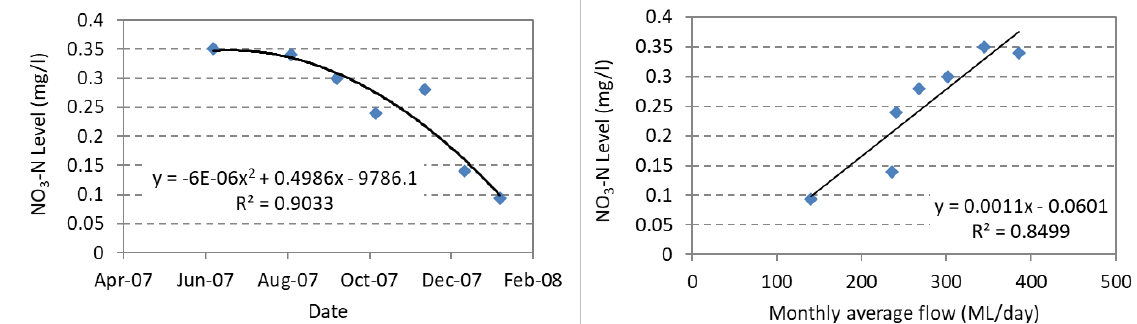
Figure 4. Seasonal pattern in NO 3 -N level and the correlation with the flow in the upper catchment of the Latrobe River.